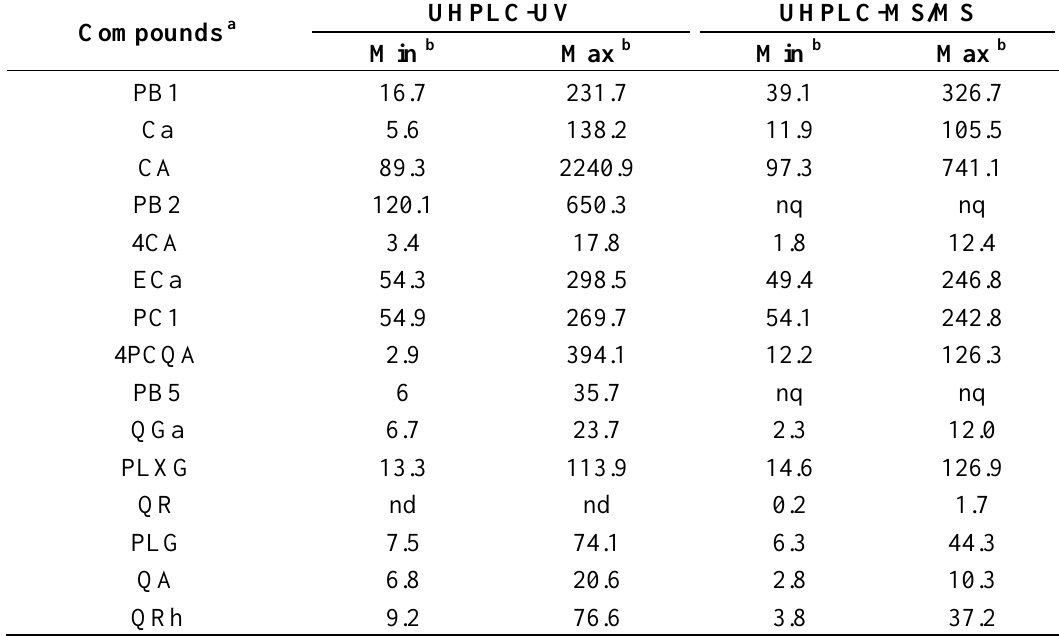
Table 3. Range of concentrations of different phenolic compounds quantified with the UV-PDA detector and the ESI-triple quadrupole mass analyzer in 120 apple juices prepared from the progeny, X5210 ×